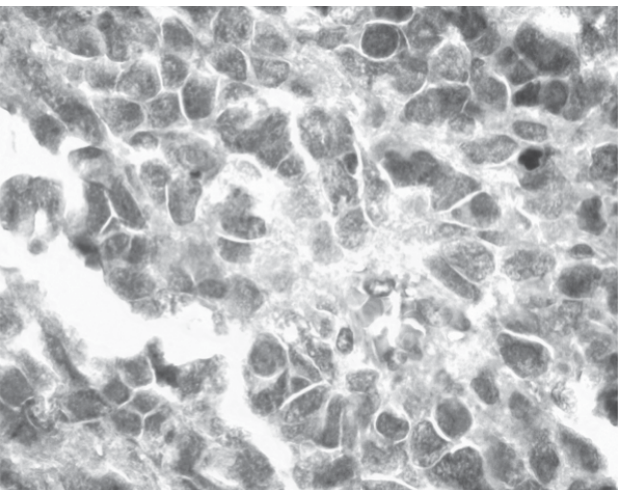
figurE – Histological section of pediatric medulloblastoma immunostained with anti- TRKC antibody showing strong positivity in the cytoplasm of neoplastic cells (400×) TRKC: receptor